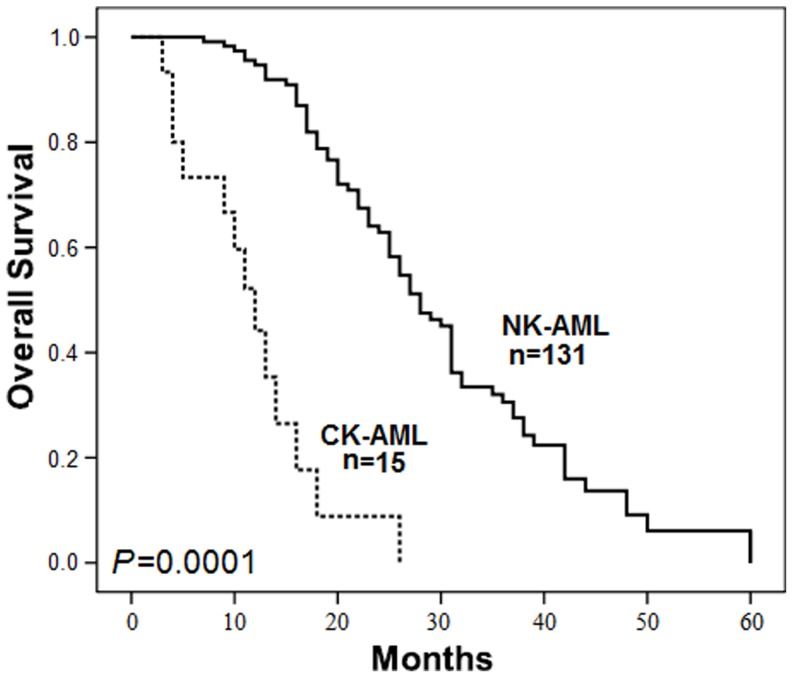
The overall survival of patients with NK-AML (solid line) and CK-AML (dotted line) analyzed by the Kaplan-Meier curve.